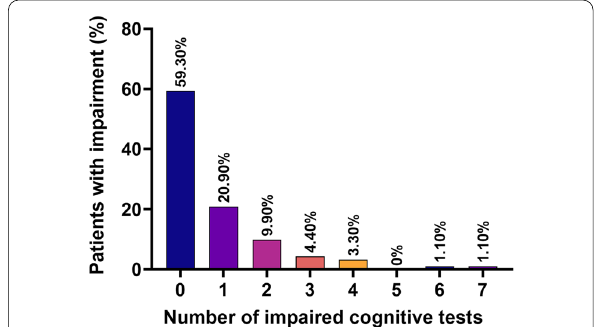
Fig. 2 The proportion of patients with the number of impaired cognitive tests, based on scores for Minimal Assessment of Cognitive Function in multiple sclerosis (MACFIMS) battery. Impairment in each test is defined as 1.5 standard deviations below the normative ≤